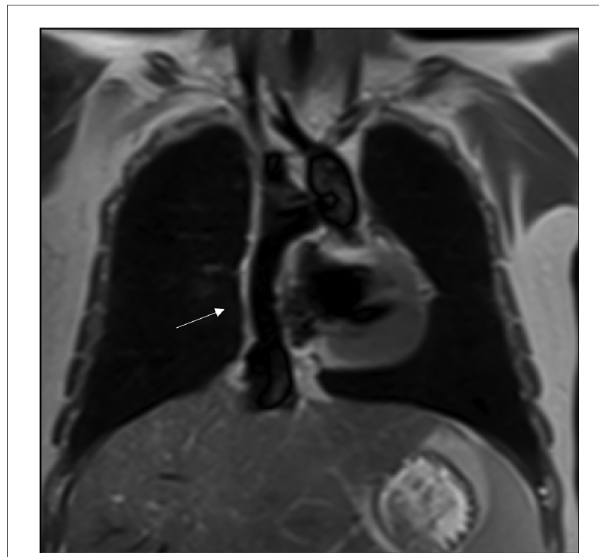
FIGURE 2 Cardiac MRI, T2 black-blood sequence in a coronal plane showing the extracardiac conduit (arrow) connecting the inferior caval vein to the pulmonary